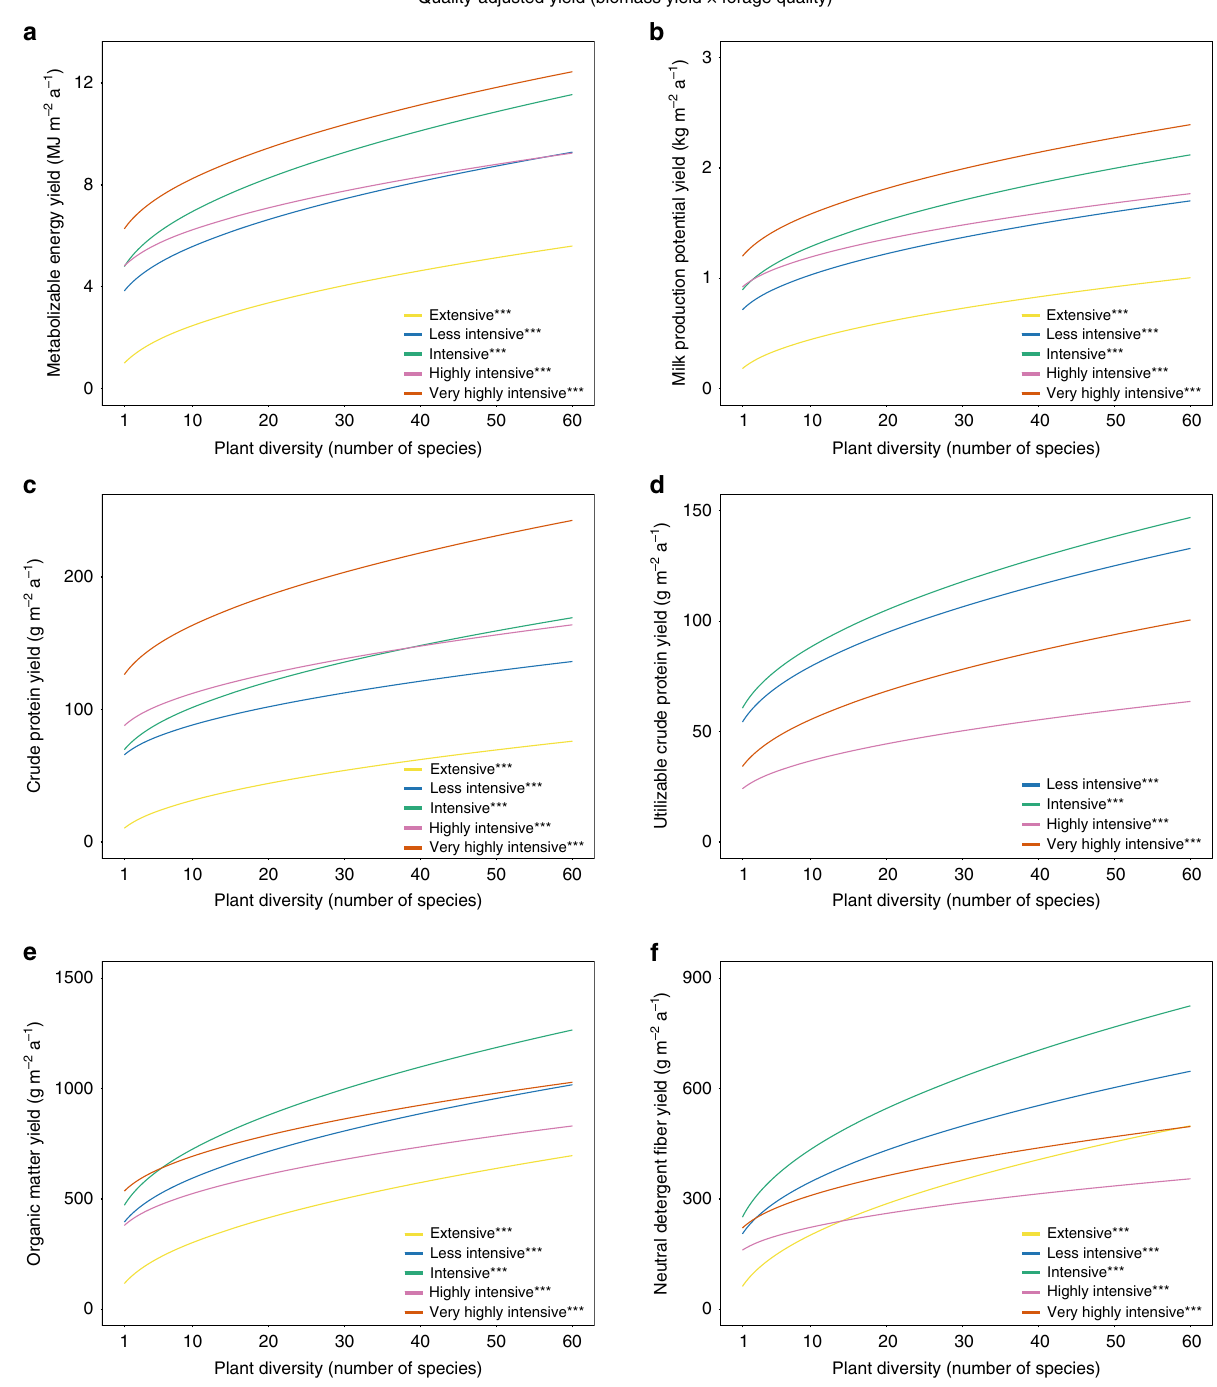
Fig. 2 Predicted values of annual quality-adjusted yields (i.e., biomass yield×forage quality). Predicted annual quality-adjusted yields as a function of plant diversity and management intensity include metabolizable energy yield (MJm − 2 a − 1 ) a , milk production potential yield (kgm − 2 a − 1 ) b , crude protein yield (gm − 2 a − 1 ) c , utilizable crude protein yield (gm − 2 a − 1) d , organic matter yield (gm − 2 a − 1 ) e , and neutral detergent fi ber yield (gm − 2 a − 1 ) f . *, **, *** denote signi fi cance at the 5%, 1%, and 0.1% level of the plant diversity effect per management intensity, respectively (corrected for multiple comparisons). The signi fi cance levels are based on a mixed effect model, see Eq. (4). The corresponding coef fi cients for the plant diversity effect per management intensity can be found in Supplementary Tables 3 – 5. Utilizable crude protein content was only measured for the fi rst cut of the year. Source data are provided as a Source Data fi fi ndings from other experiments that investigated yields of crude protein and energy 22,25,27 – 29 . Further con fi rmation is given by studies that only reported biomass yield and forage quality but not quality-adjusted yield 21,23,24,26 .